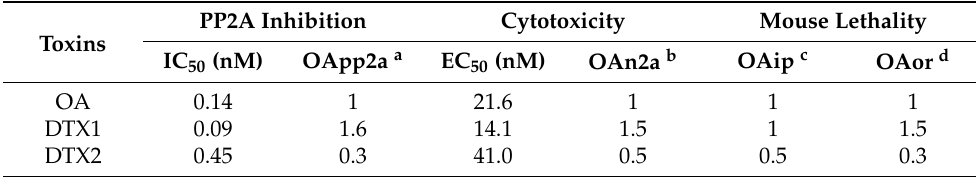
Figure 2. Dose-dependent curves for the inhibition of rPP2A activity by OA ( a ), DTX1 ( b ), and DTX2 ( c ). Each point represents the mean (n = 6) with an intra-plate SD of less than 2%. Table 1. IC 50 values of OAs in the PP2A inhibition assay, EC 50 values of OAs in the neuro-2a assay, and comparison of OA equivalents for OAs based on the PP2A inhibition, cytotoxicity, and mouse